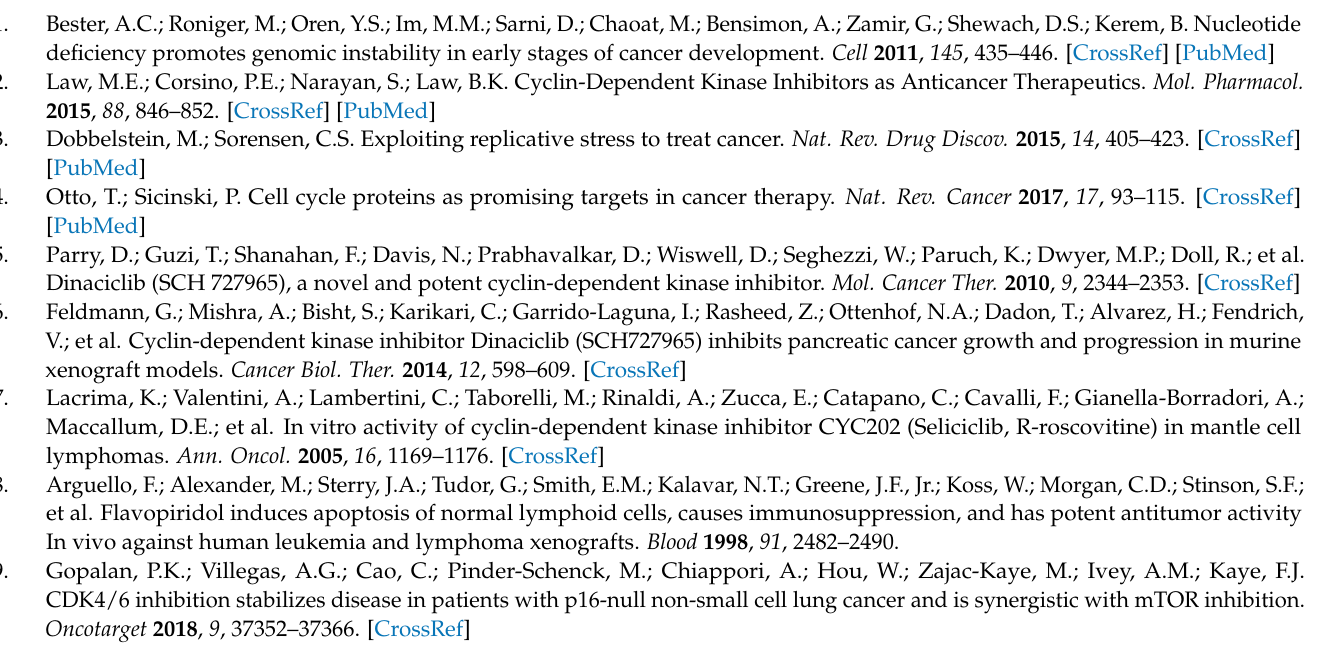
Figure S2: ( a ) DGG200064 dose-dependently induces c-Jun on HCT116 cells; ( b ) DGG200064 does not affect the ubiquitination of cyclin E, Table S1: In vivo evaluation of the DGG200066 suppressed colon cancer tumor growth against HCT1116